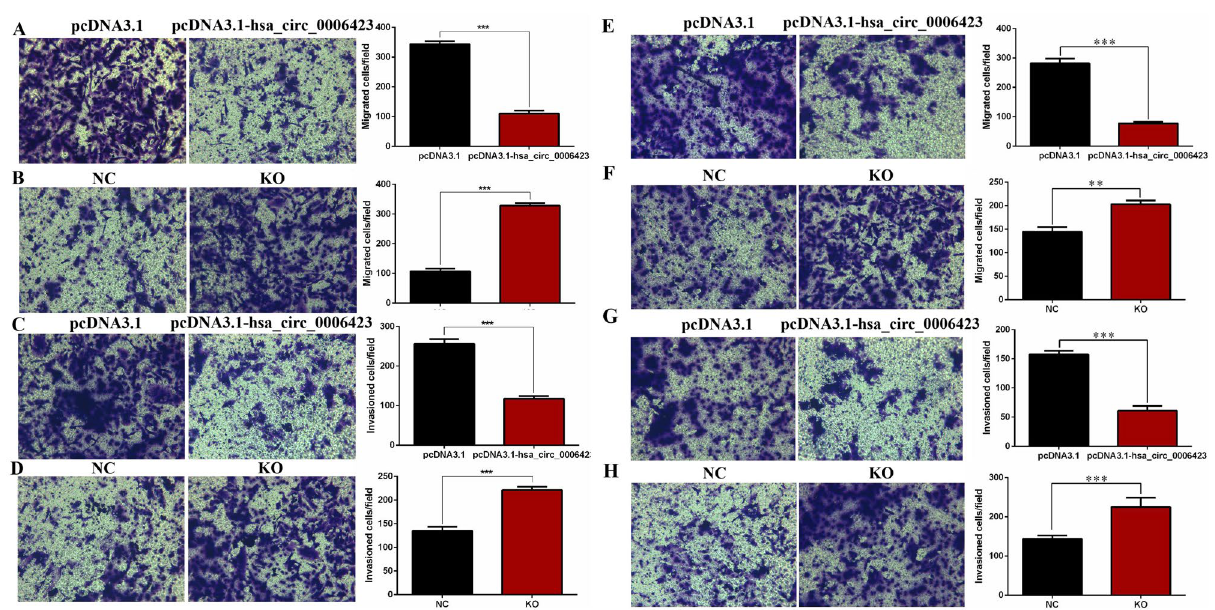
Figure 6. Effects of hsa_circ_0006423 on NSCLC cell lines migration and invasion. ( A ) Cell migration numbers of A549 following overexpression of hsa_circ_0006423. ( B ) Cell migration numbers of A549 following silencing of hsa_circ_0006423. ( C ) Cell invasion numbers of A549 following overexpression of hsa_circ_0006423. ( D ) Cell invasion numbers of A549 following silencing of hsa_circ_0006423. ( E ) Cell migration numbers of NCI- H1299 following overexpression of hsa_circ_0006423. ( F ) Cell migration numbers of NCI-H1299 following silencing of hsa_circ_0006423. ( G ) Cell invasion numbers of NCI-H1299 following overexpression of